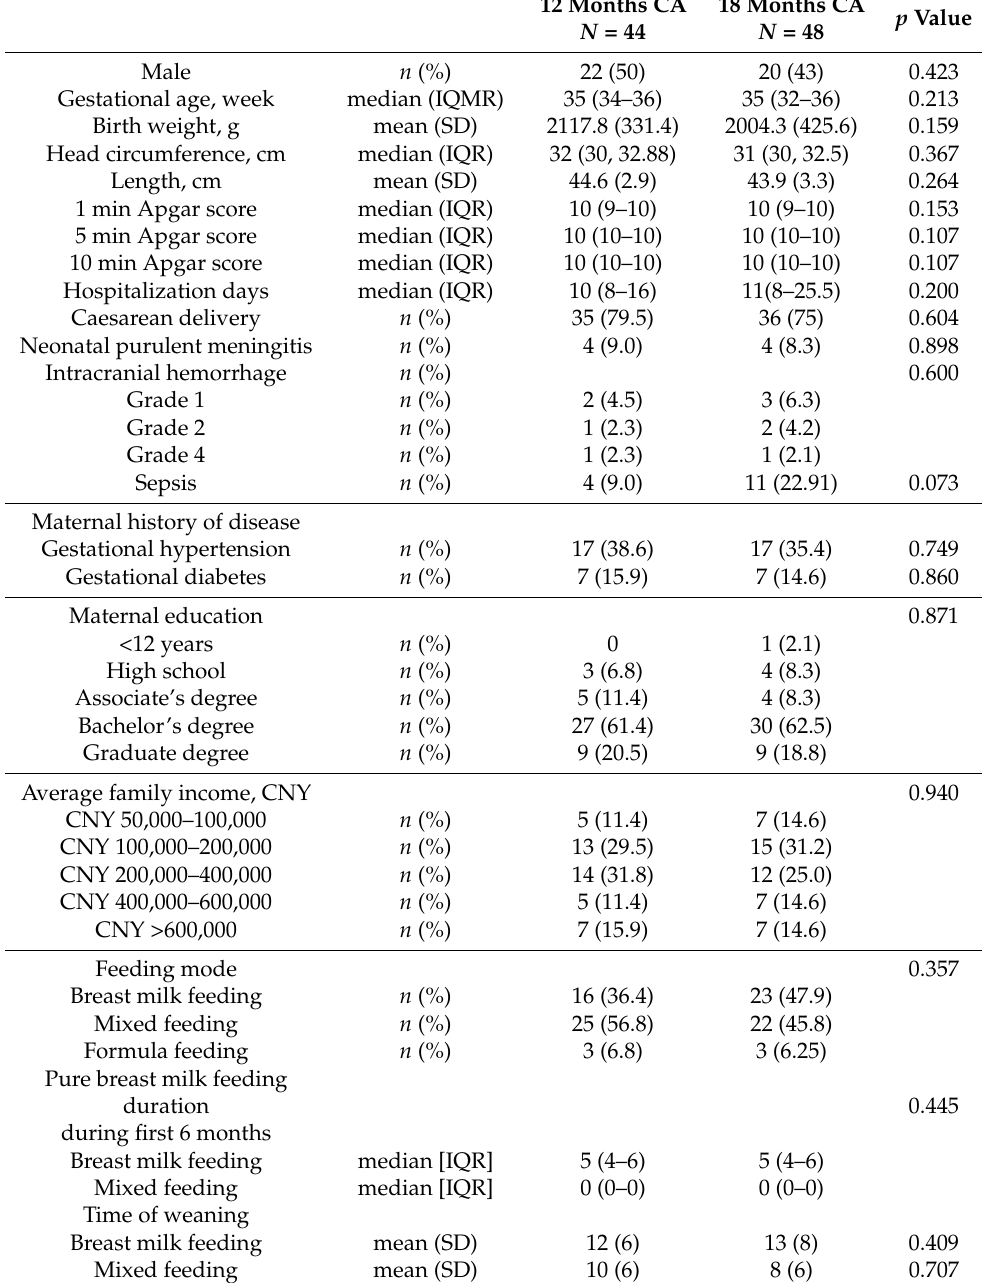
Table 2. Clinical and sociodemographic characteristics of study population at 12 and 18 months